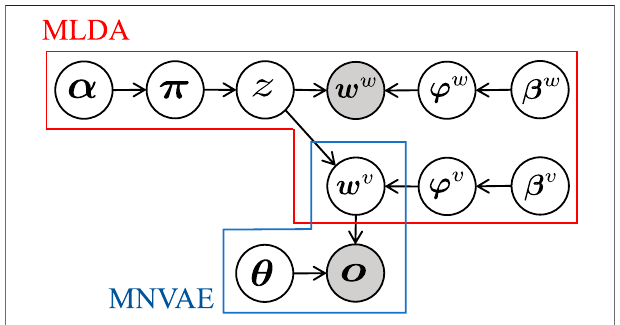
FIGURE2| GraphicalrepresentationofintegratedmodelofMNVAEand MLDA.